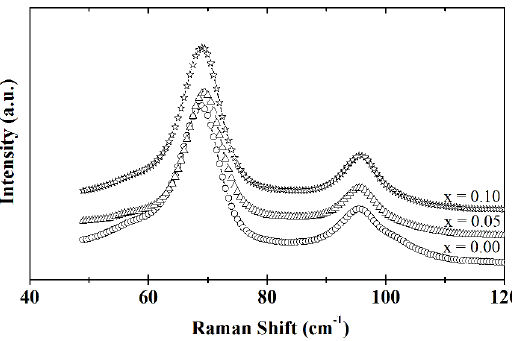
Figure 6. Room temperature Raman spectra of polycrystalline Bi Ni Fe samples. 3 1-x x